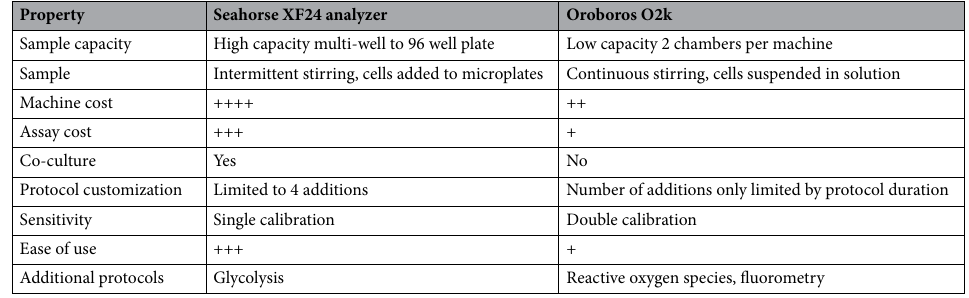
Table 2. Brief comparative evaluation of Seahorse XF24 Analyzer and Oroboros O2k by metrics relevant to potential